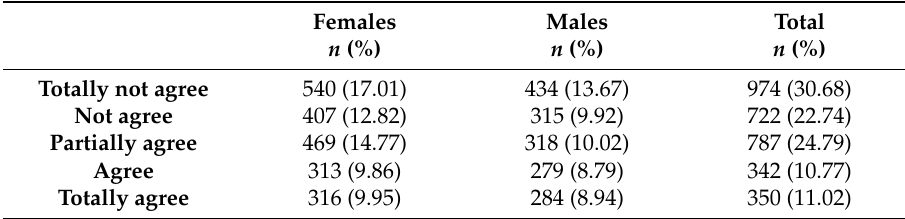
Table 4. Association between sex and agreement to work in an institution run by private equity or insurance companies.